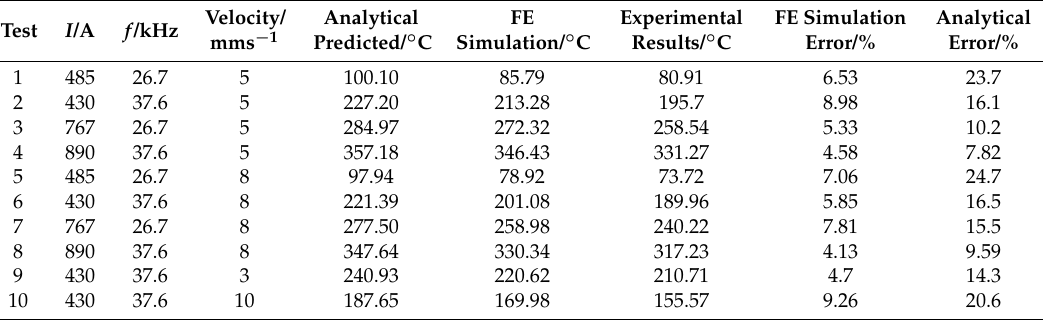
Figure 17. Maximum temperature validation in the surface of the workpiece ( I = 430 A, f = 37.6 kHz, Table 2. Maximum temperature and the relative errors with experimental results.